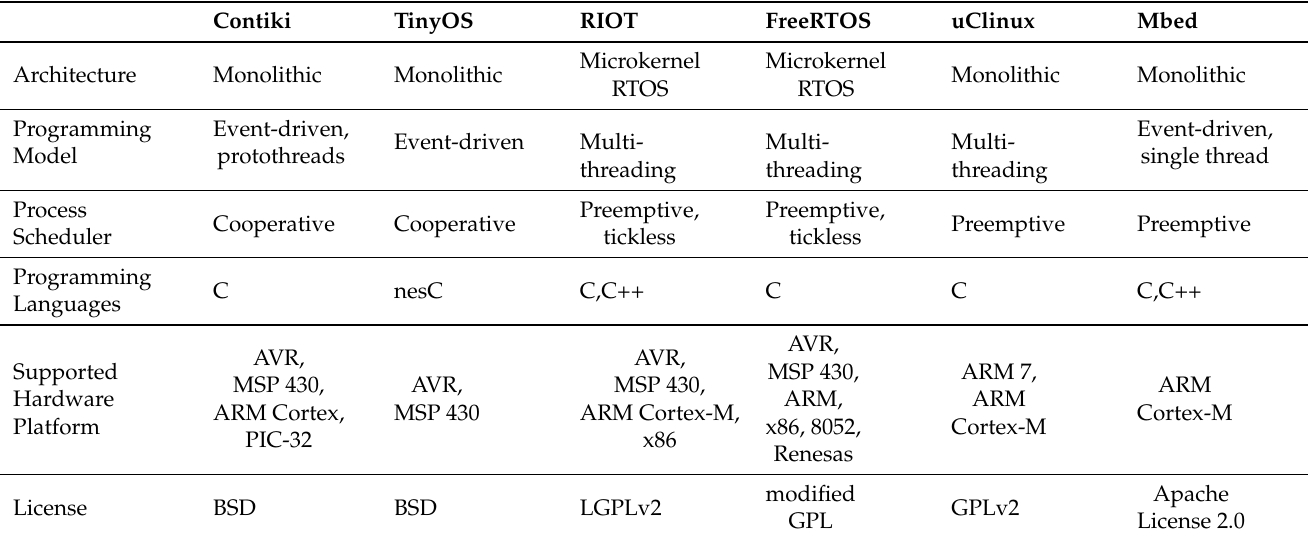
Table 4. IoT operating systems design